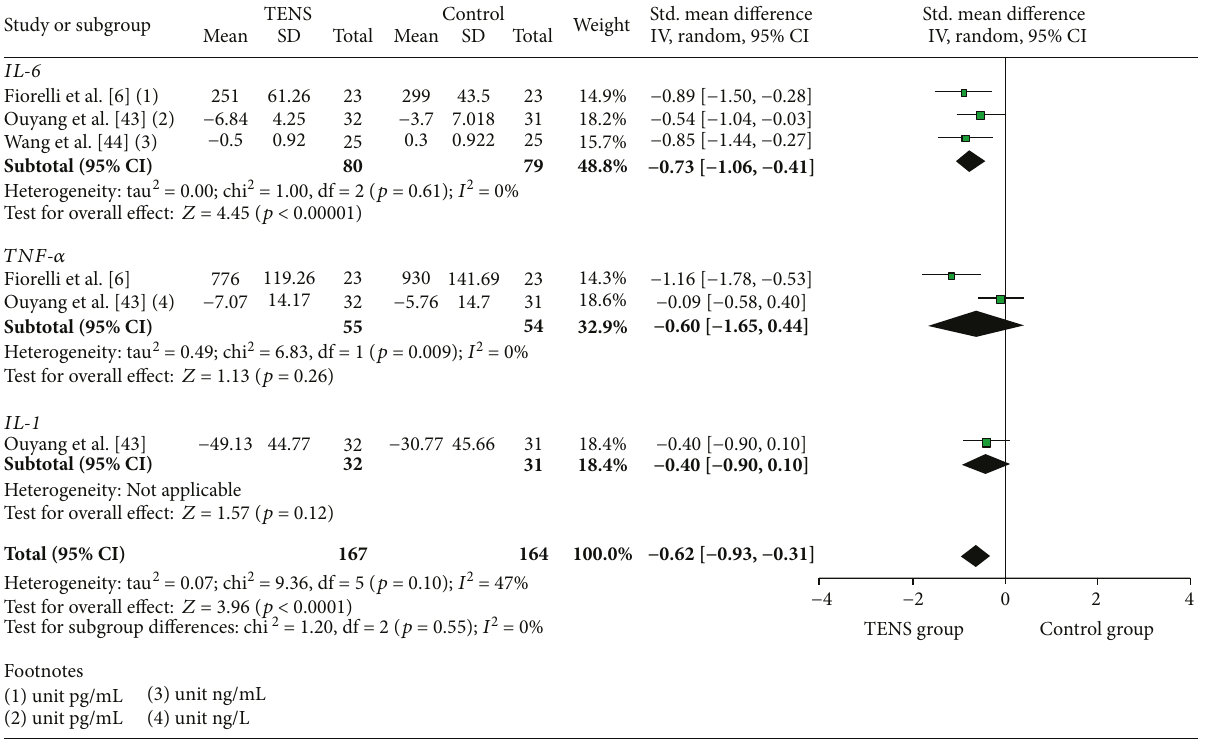
Figure 4: Meta-analysis of the general e ff ect of TENS on proin fl ammatory